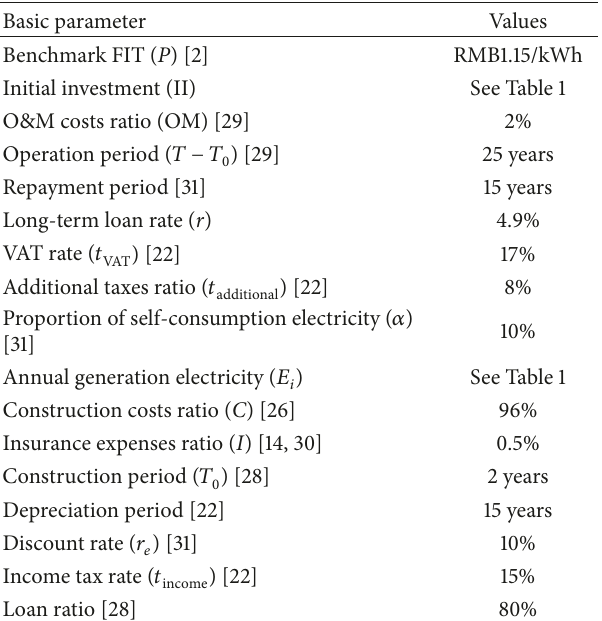
Table 2: Parameters values and data related to the CSP systems of